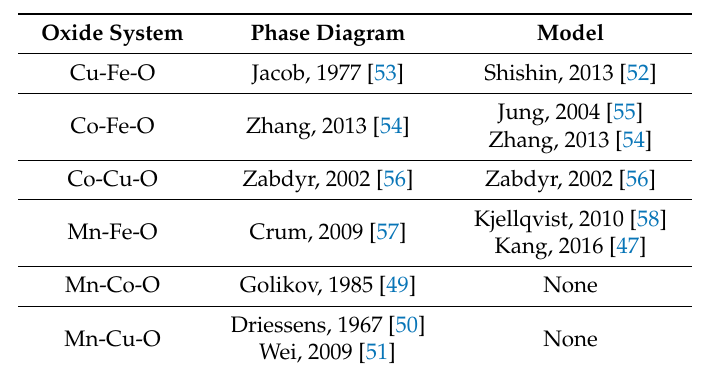
Table 2. Summary of available phase diagrams and thermodynamic models for the ternary